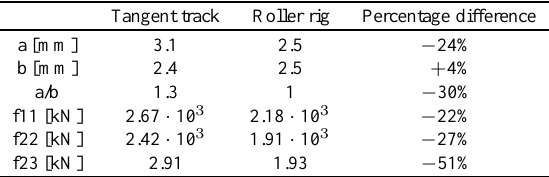
Table 1 Discrepancies between the contact coefficients involved in the linear theory. Only the wheelset mass is considered